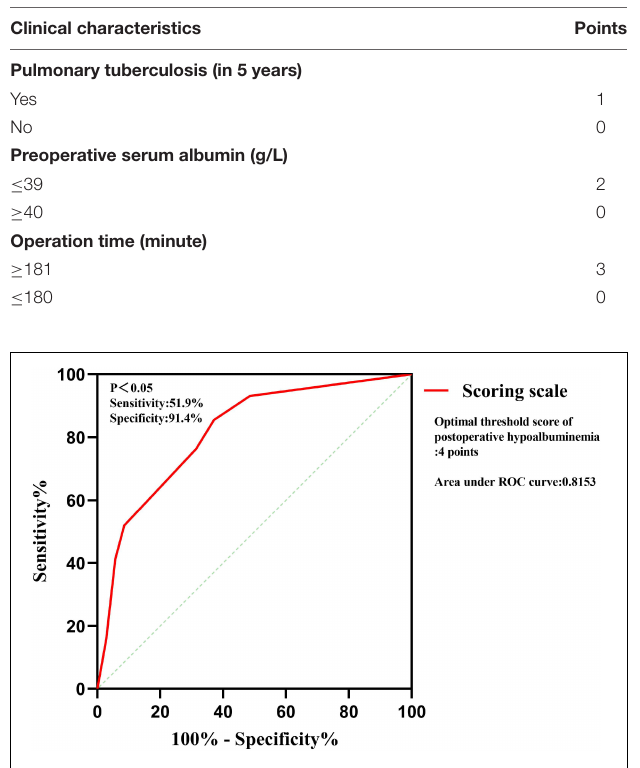
TABLE 4 | Scoring scale for occurrence of postoperative hypoalbuminemia.